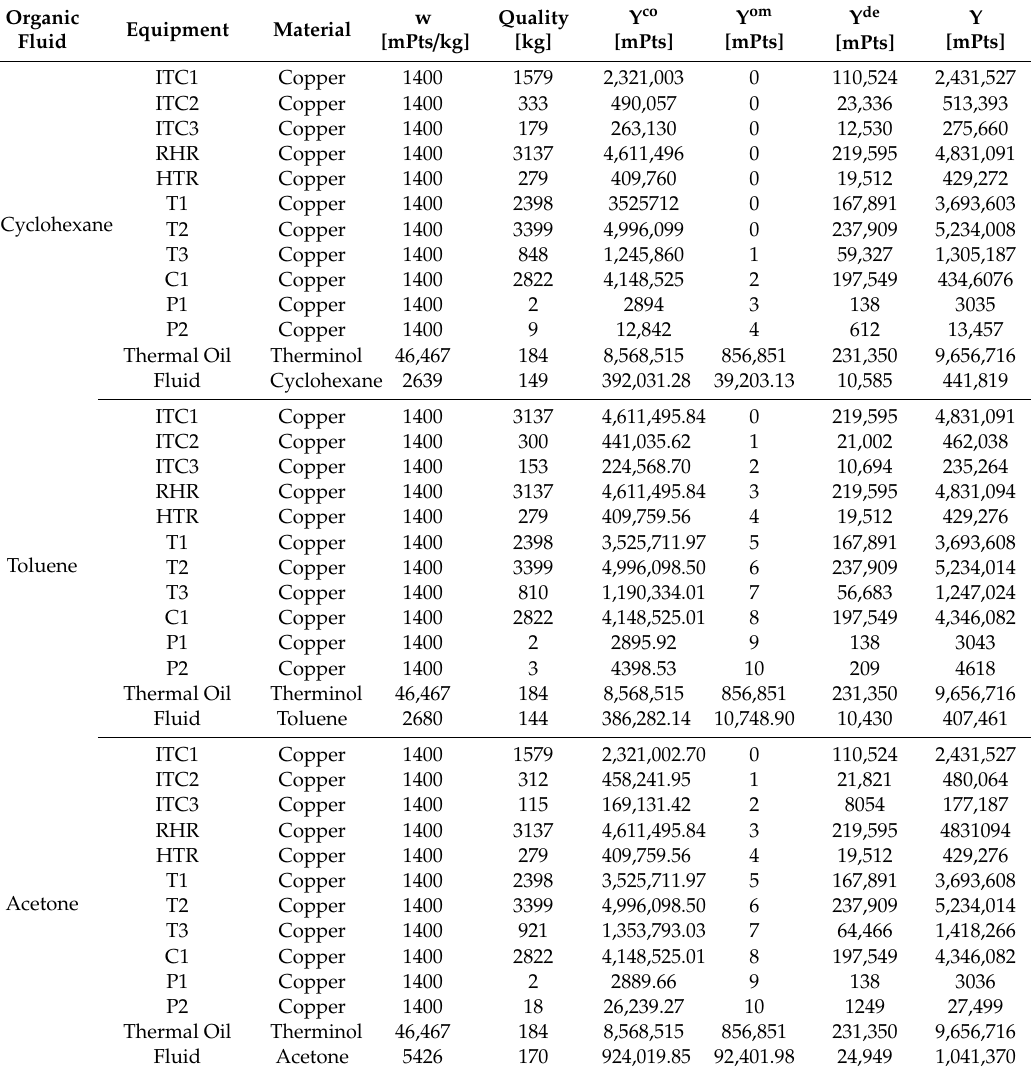
Table A1. Results of Life Cycle Assessment for each component selecting copper as the